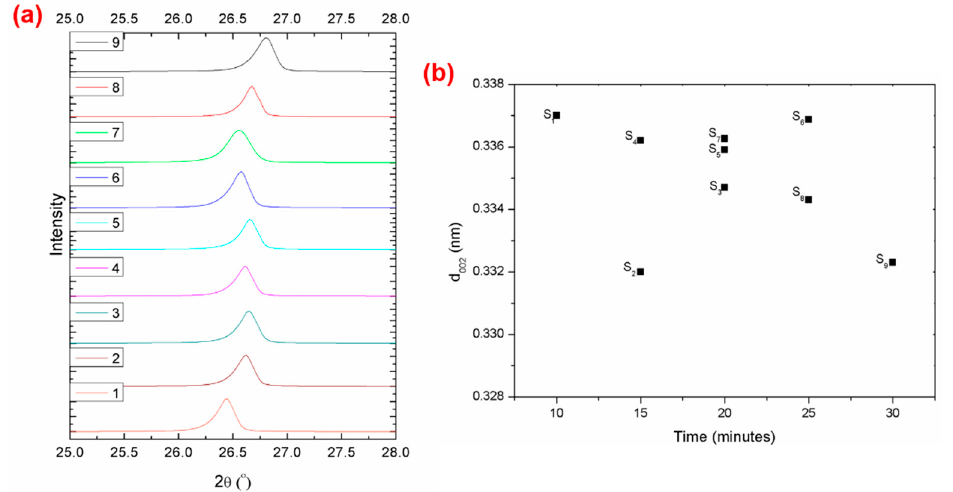
Figure 2. ( a ) XRD pattern of different composite compositions at 25° to 28°, and ( b ) changes in d 002 at different processing times.